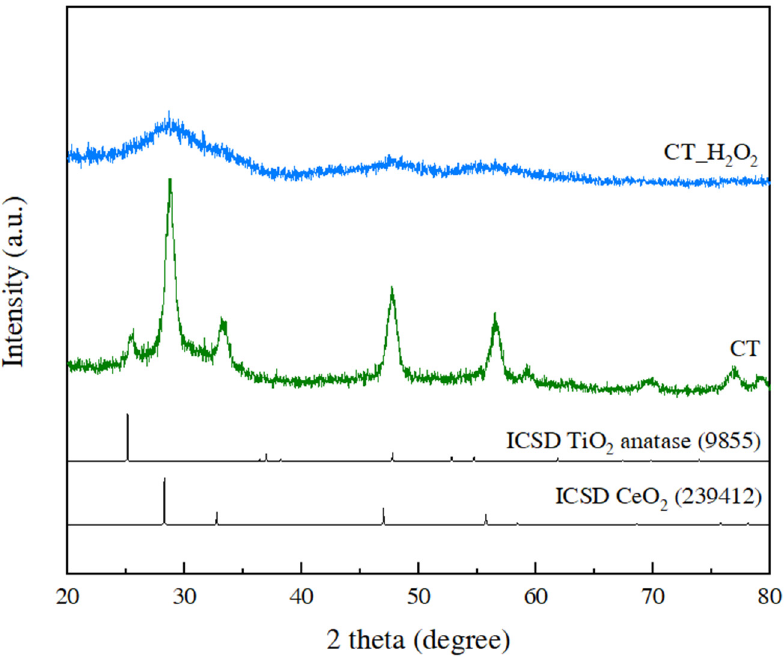
Figure 1. XRD patterns of CT and CT_H 2 O 2.